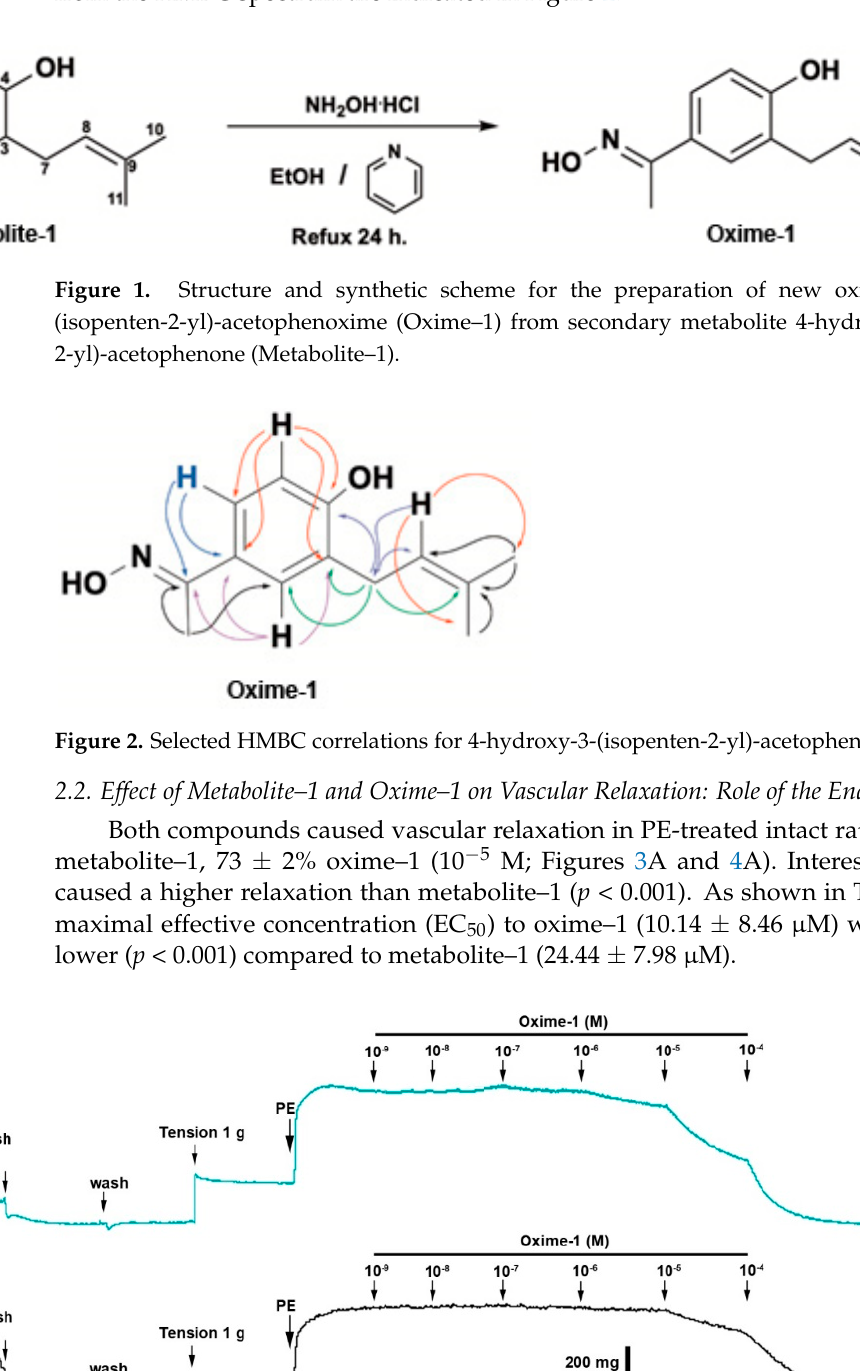
Figure 4. Metabolite–1 and oxime–1 cause relaxation in rat aorta via the endothelium-dependent pathway. Aortic rings were pre-contracted with 10 − 6 M PE, and cumulative concentrations of mole- cules (10 − 9 to 10 − 4 M) were added in bath. The protocol was repeated in intact rat aorta ( A ), and endothelium-denuded aorta ( B ). Data are presented as the average standard error of the mean (SEM) of 4–6 independent experiments. * p < 0.05; *** p < 0.001. To evaluate whether the release of endothelial factors was involved, the vascular tis- sue was pre-incubated with an inhibitor of endothelial nitric oxide synthase (NOS) [26]. We found that the pre-incubation of the intact aortic rings with 10 − 4 M L-NAME signifi- cantly decreased relaxation to 10 − 5 M concentration: metabolite–1, 41 ± 6% vs. 22 ± 5% L- NAME, p < 0.001 (Figure 5A); oxime–1, 73 ± 2% vs. 42 ± 9% L-NAME, p < 0.01 (Figure 5B).